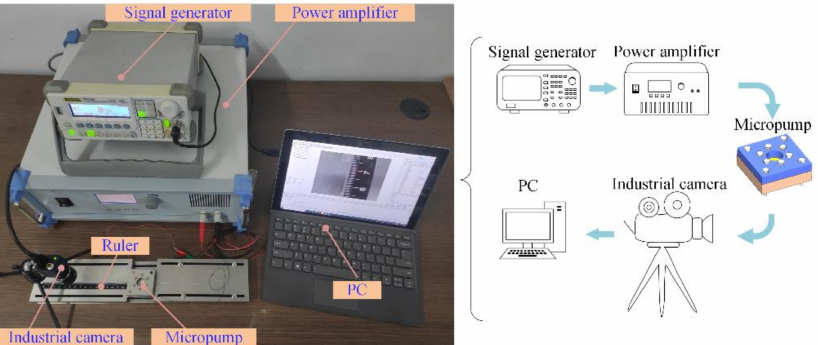
Figure 10. The experimental platform